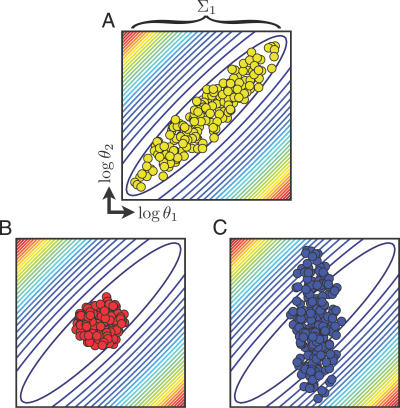
Sloppiness and UncertaintiesAs in Figure 1A, the contours represent surfaces of constant model behavior deviation. The clouds of points represent parameter set ensembles.(A) Collective fitting of model parameters naturally constrains the parameter set ensemble along stiff directions and allows it to expand along sloppy directions. The resulting ensemble may be very large, yet encompass little variation in model behavior, yielding small prediction uncertainties despite large parameter uncertainties. (Σ1 denotes the 95% confidence for the value of θ
1.)(B) If all parameters are directly measured to the same precision, the parameter set ensemble is spherical. The measurement precision required for well-constrained predictions is set by the stiffest direction.(C) If one parameter (here θ
2) is known less precisely than the rest, the cloud is ellipsoidal. If not aligned with a sloppy direction, the cloud will admit many model behaviors and yield large prediction uncertainties. (Note that the aspect ratio of the real contours can be greater than 1,000.)